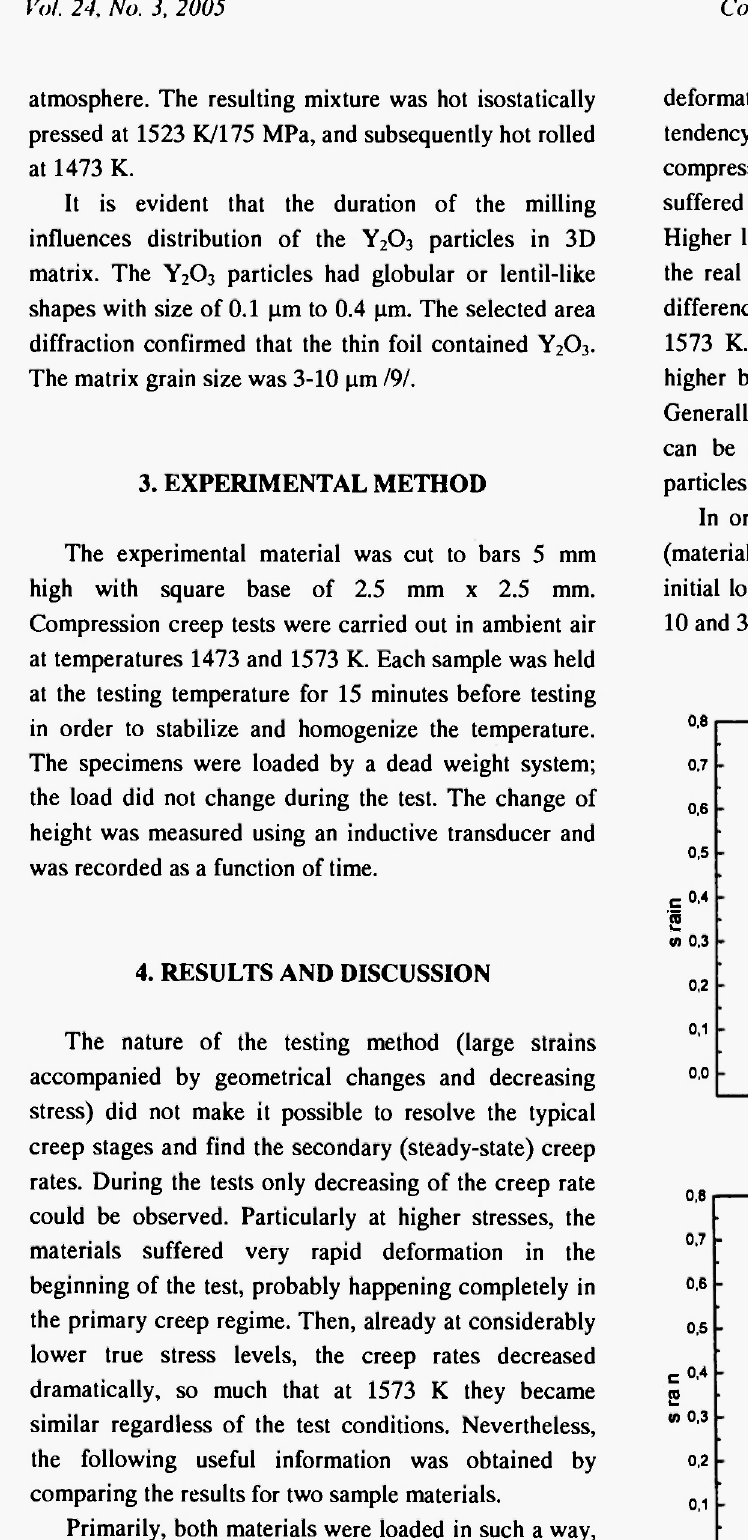
Fig. 1: Creep curves of the material